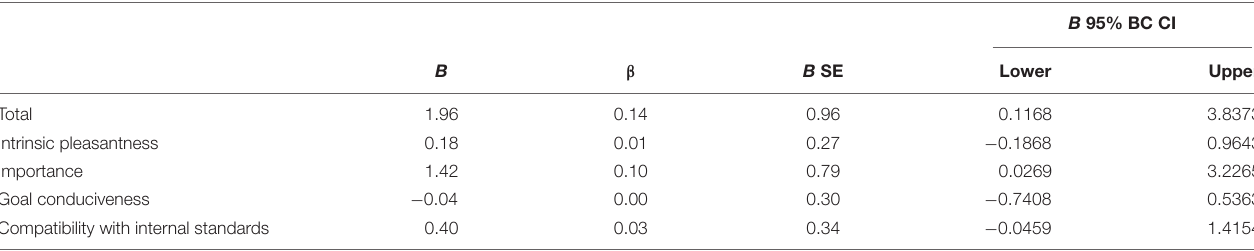
FIGURE 2 | Mediation model of affiliative extraversion and positive activation through appraisals. All coefficients represent unstandardized (standardized) regression coefficients, controlling for Assertiveness and baseline positive activation scores. Bold lines represent significant coefficients, p < 0.05. TABLE 5 | Unstandardized (B) and standardized ( β ), standard errors and bias-corrected confidence intervals of the mediation model testing the indirect effects of the affiliative extraversion on positive activation through appraisals following the family